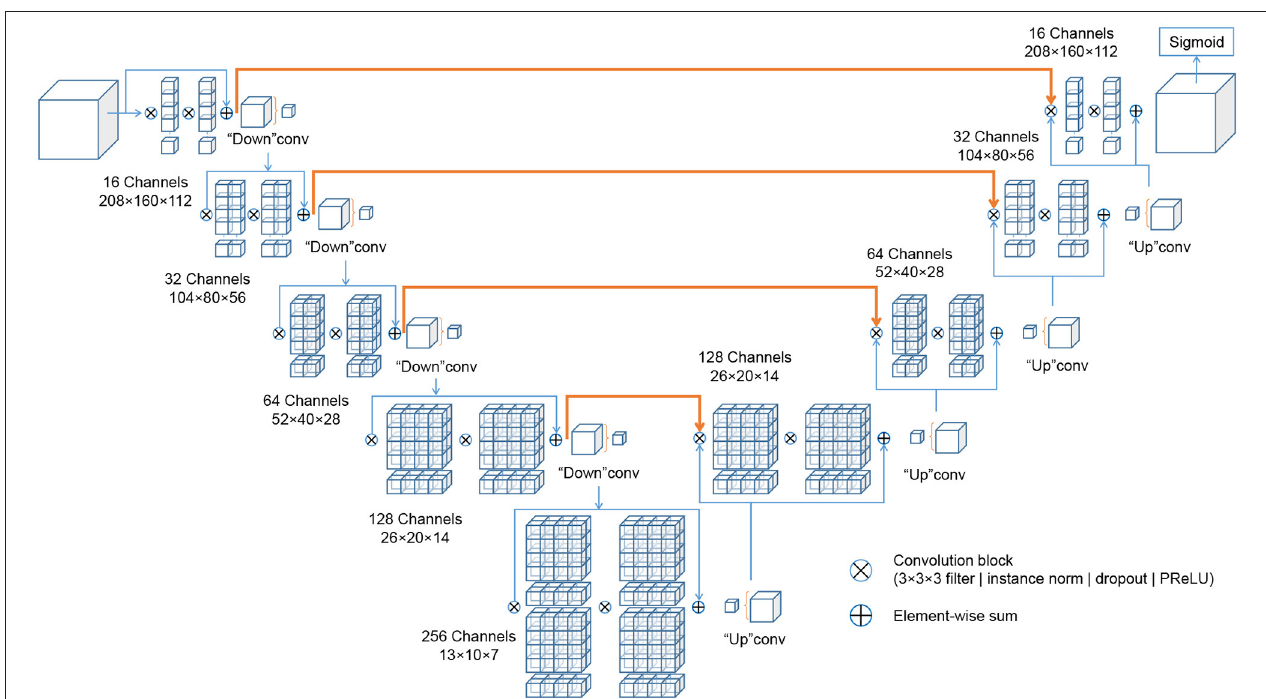
FIGURE 3 | Schematic representation of the IE-Vnet architecture. The IE-Vnet architecture is designed as a variant of a V-Net architecture with four down-sampling levels, [16,32,64,128,256] 3D-convolutional filters at each level (kernel size: 3 × 3 × 3 voxels), and with residual blocks spreading two convolutional layers each within each level. Each convolutional layer is followed by Instance Normalization ( 50), channel-wise random dropout ( p = 0.5), and non-linear activation with Parametrized Rectified Linear Units (PReLU) (51). The convolutions aim to extract features from the data and, at the end of each stage, reduce its resolution by using appropriate stride. The left part of the network consists of a compression path, while the right part decompresses the signal until its original size is reached. A more detailed description can be found in Milletari et al. (48).